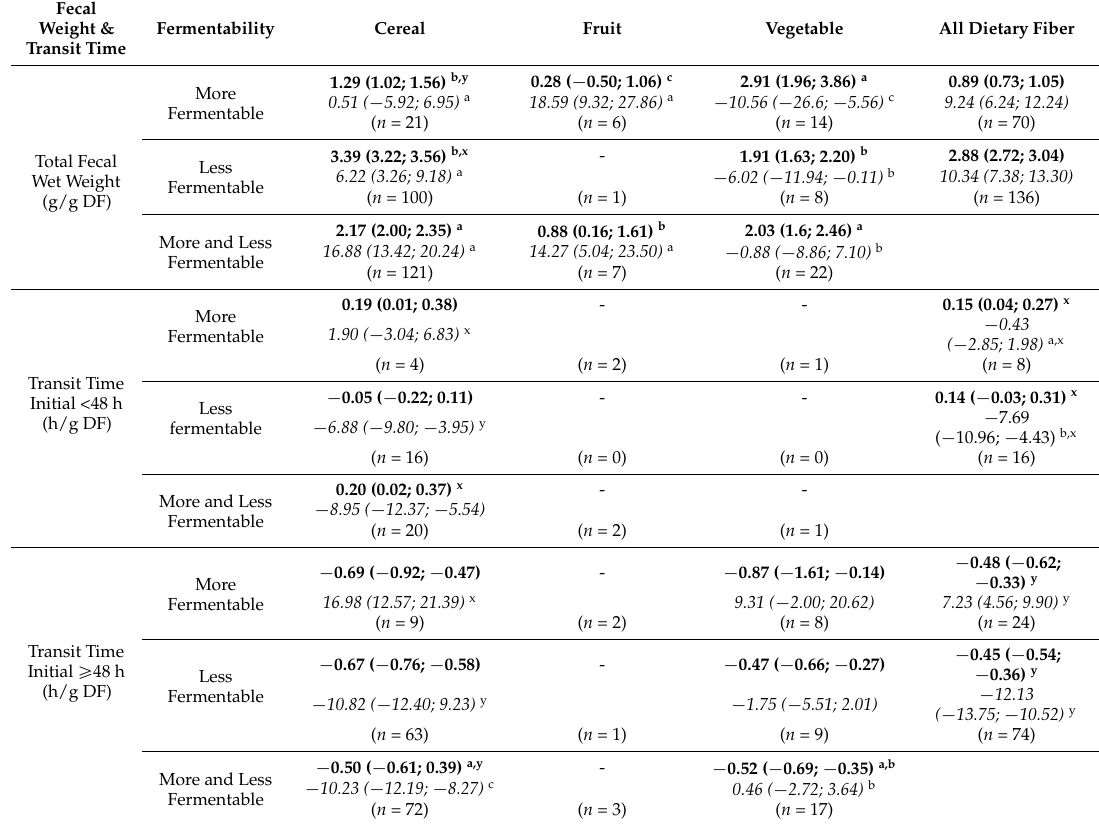
1 Bold figures represent the slope of the regression line; italic figures represent the intercept of the regression line; 2 the results of the table are based on all available data on the effects of dietary fibers on total stool weight